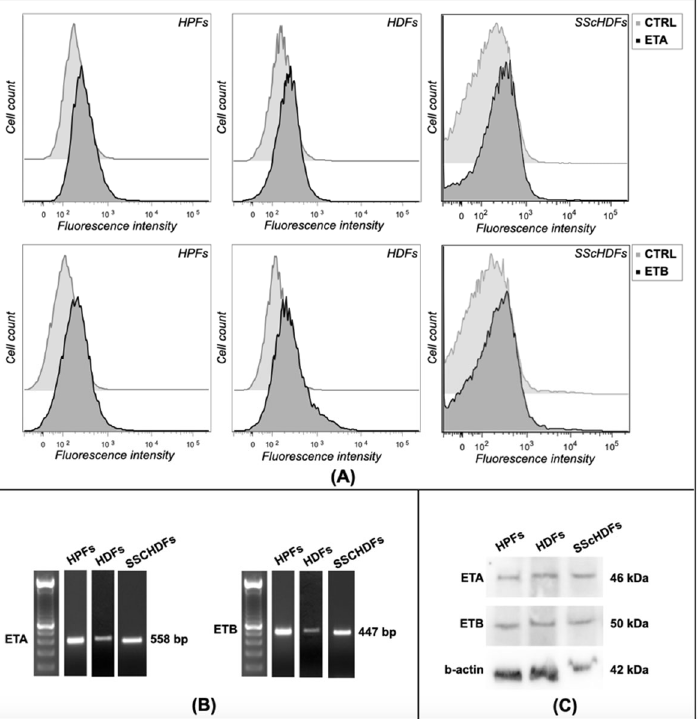
Figure 1. ET receptor detection in fibroblasts. ( A ) Expression of ET receptors was analyzed with flow cytometry, and ( B ) RT ‐ PCR and ( C ) Western blot analysis in HPFs, HDFs, and SScHDFs. Both ET receptors were detected in the cells analyzed both at the mRNA level and at the protein level. (HPFs: human pulmonary fibroblasts; HDFs: human dermal fibroblasts; SScHDFs: scleroderma dermal fibroblasts; ETA: endothelin receptor A; ETB: endothelin receptor B).